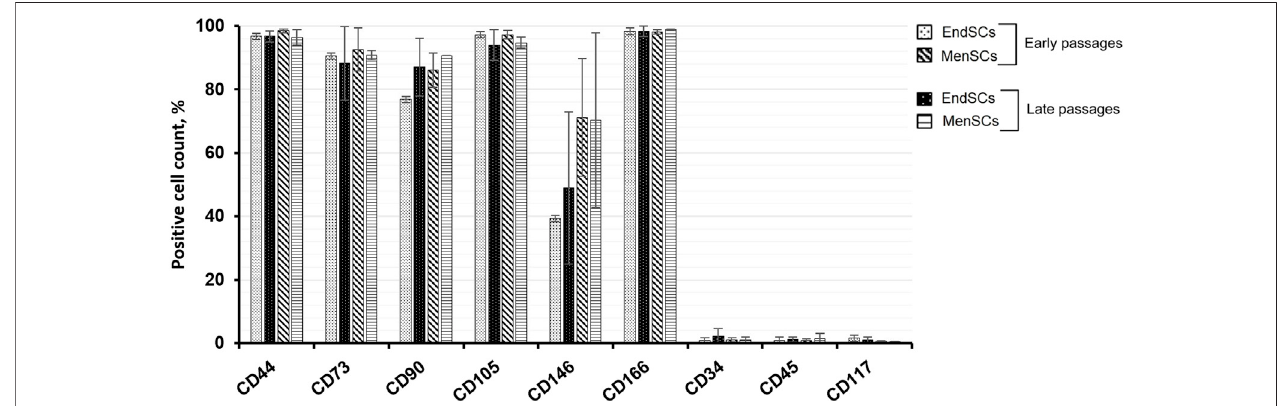
FIGURE 1| EndSCs and MenSCs cell surface markers analysis. The expression of typical mesenchymal stem cells markers CD44, CD73, CD90, CD105, CD166; hematopoietic progenitor cells and endothelial cells markers CD34, CD45, CD117 and CD146 were detected at early and late passages using fl ow cytometry. Results are presented as mean ± SD ( n (cid:2) 3).